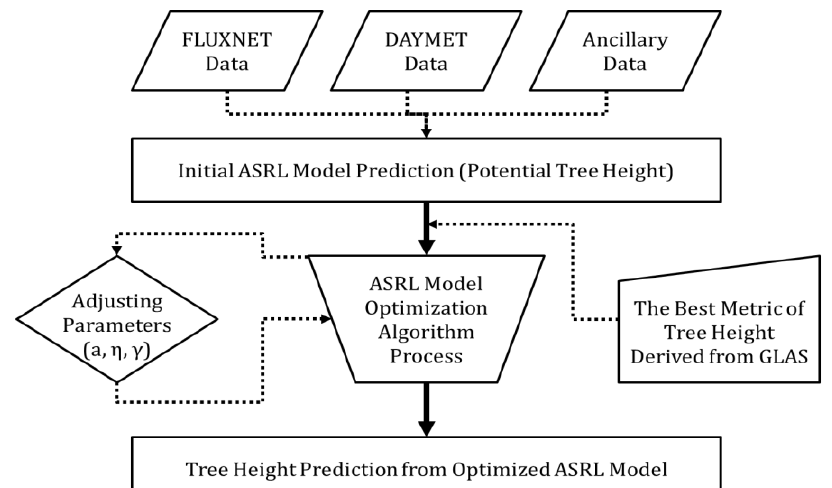
Figure 3. Diagram showing ASRL model optimization. The model predicts potential tree heights (initial prediction) using climatic and ancillary data. Three allometric scaling parameters of the model (area of single leaf, α; exponent for canopy radius, η; and root absorption efficiency, γ) are simultaneously adjusted to find the minimum of the difference between GLAS tree heights and model predictions. GLAS tree heights are estimated using the best GLAS metric that closely resembles field-measured and LVIS tree heights amongst five GLAS height metrics (Table